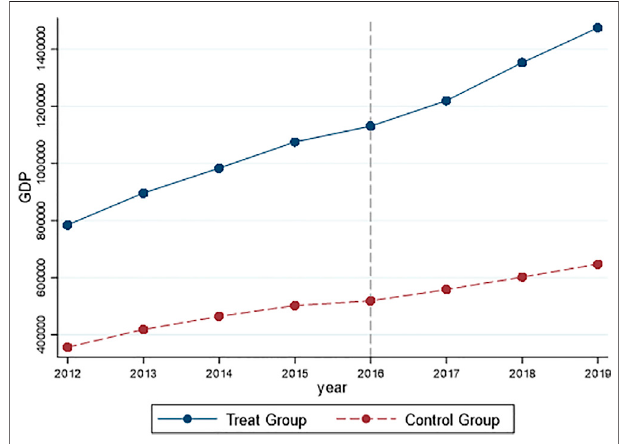
FIGURE 2 | GDP in poverty-stricken counties.